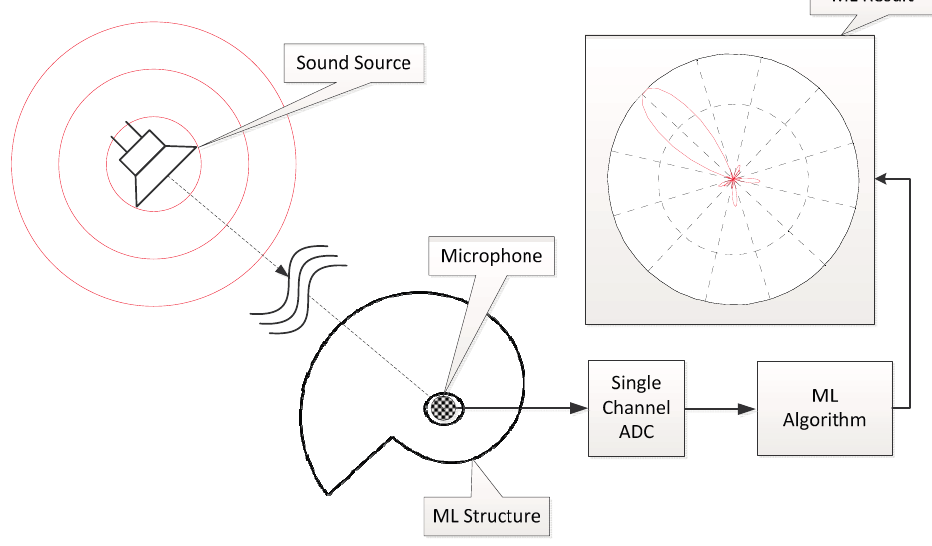
Figure 1. The functional diagram of the ML